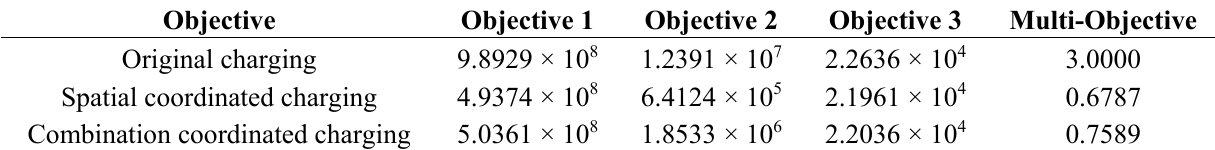
Table 6. Sub-objective value of spatial coordinated charging strategy.